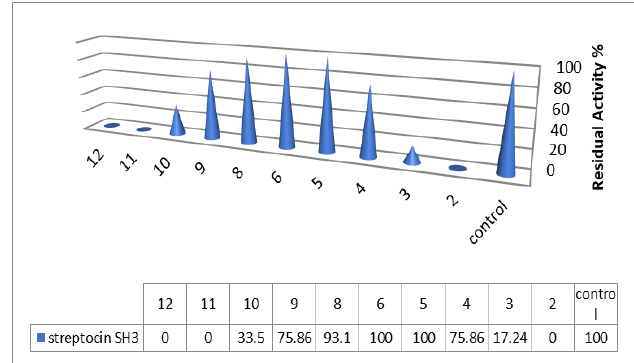
Figure.5 : pH stability of streptocin